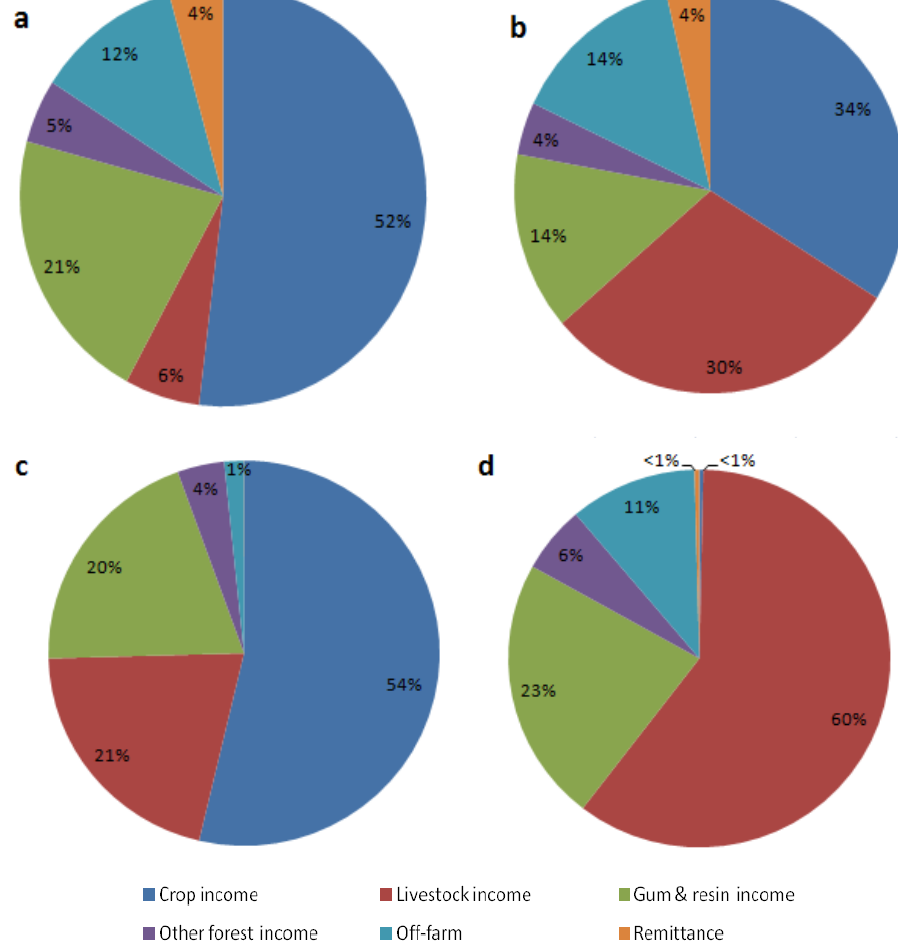
Figure 2. The share of major income sources in total household income across the study areas: ( a ) Ummrawaba; ( b ) Elnehud; ( c ) Abergelle and ( d )